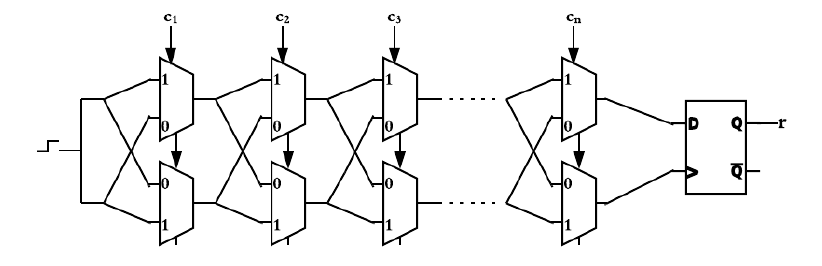
Figure 1. Structure of Arbiter PUF.